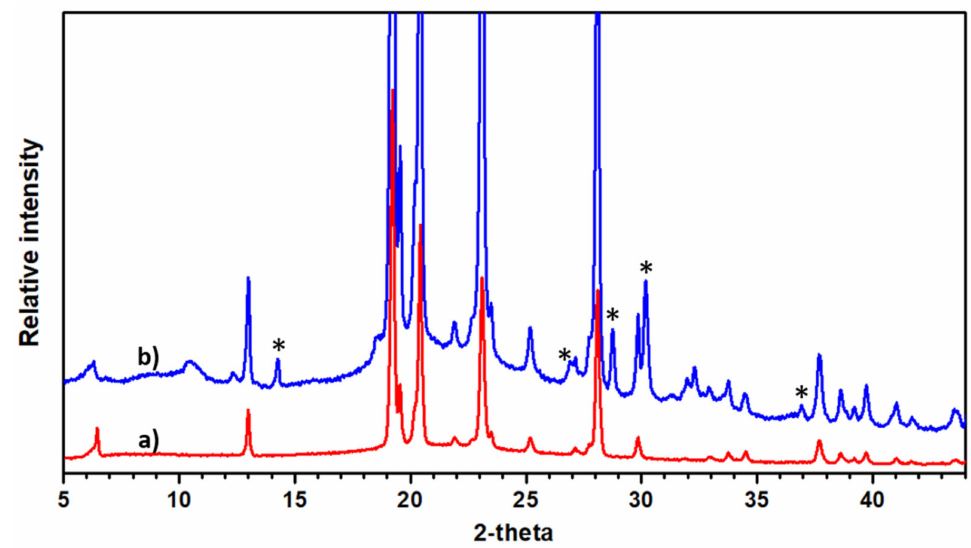
Figure 5. The φ 3-K pattern ( a ) compared with the pristine material ( b ). KNH 2 impurity is indicated with asterisks. Extra peaks can be attributed to (00l) lines with a c parameter value of 14.34 Å.